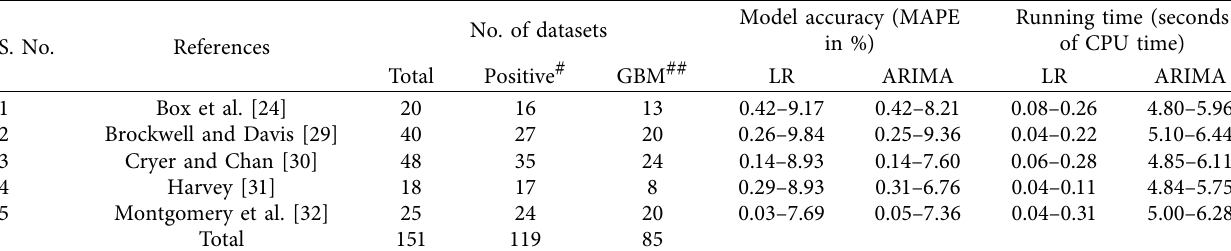
Table 1: Results of an exploratory study.